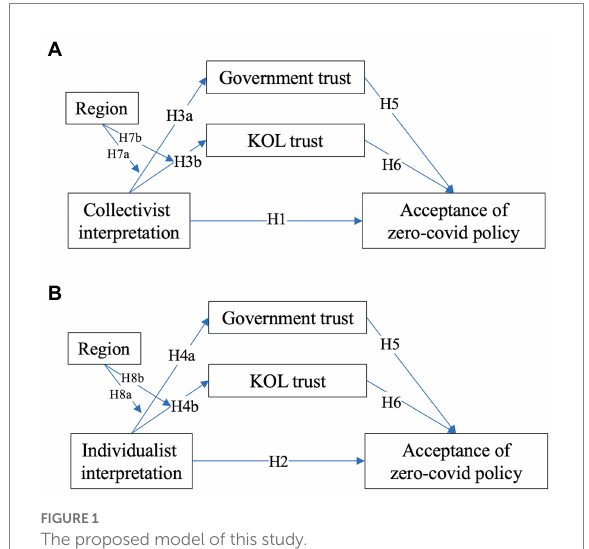
FIGURE 1 The proposed model of this